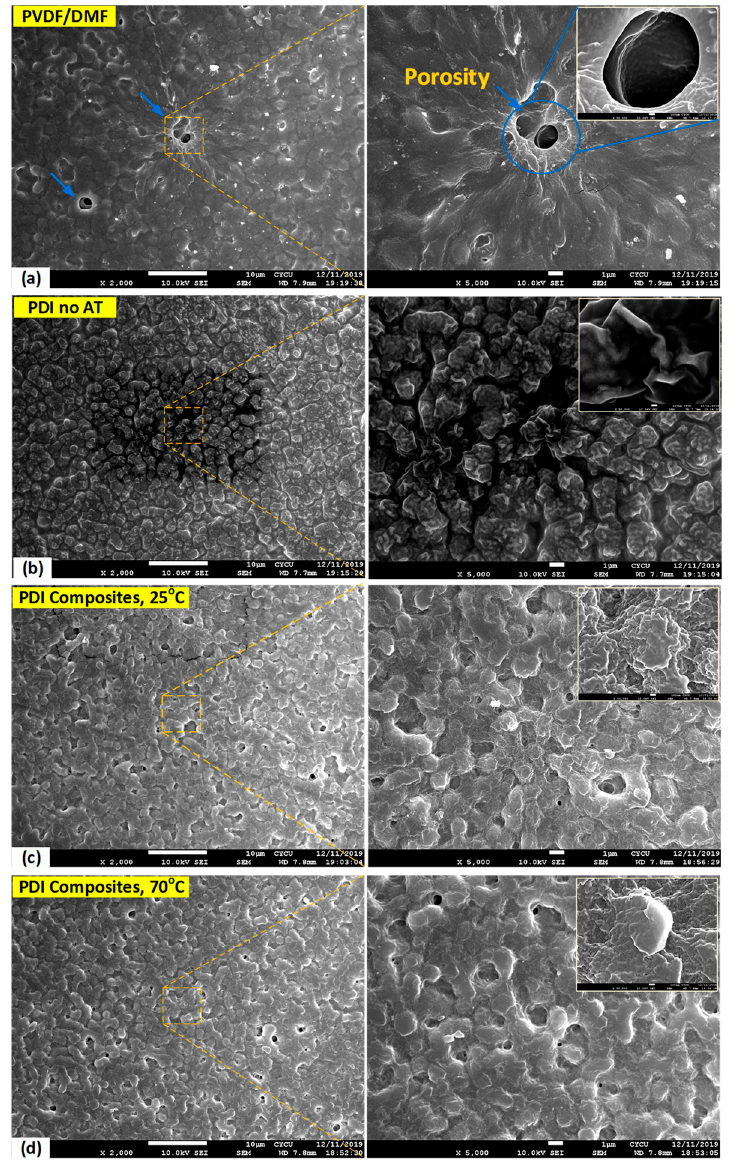
Figure 11. SEM images of ( a ) PVDF/DMF, ( b ) PDI no_AT, and ( c )( d ) PDI annealed at 25 °C and 70 °C.